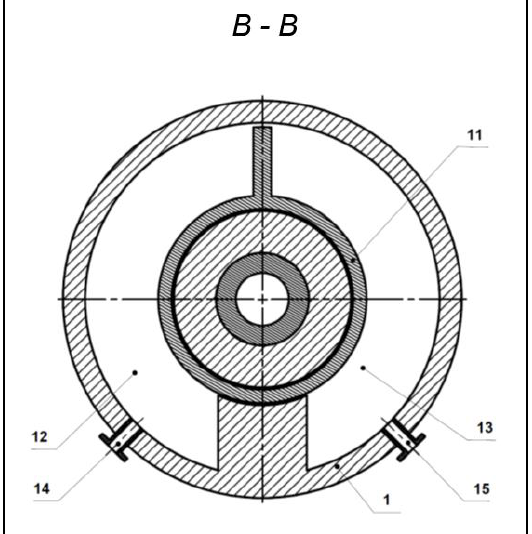
Figure 7. B−B cross-section of the mesh turbine using a rotary hydraulic cylinder: 1- stator; 11- movable control sleeve; 12 and 13- hydraulic chambers; 14 and 15- through